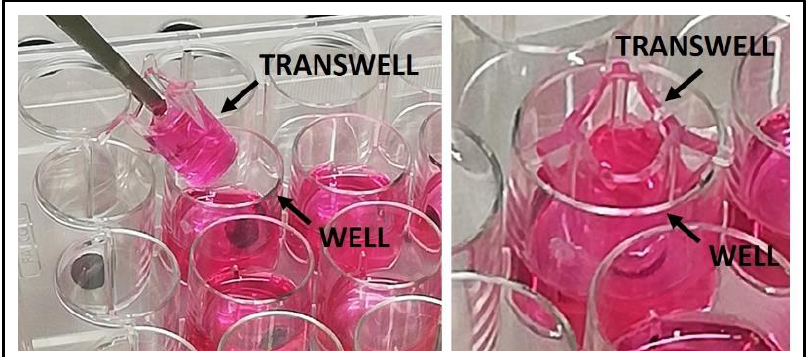
Figure 3. The set-up of the indirect co-culture with well and transwell device. The transwell has to fit perfectly into the well allowing the plate lid to close. Tweezers are used to remove the transwell from the well.